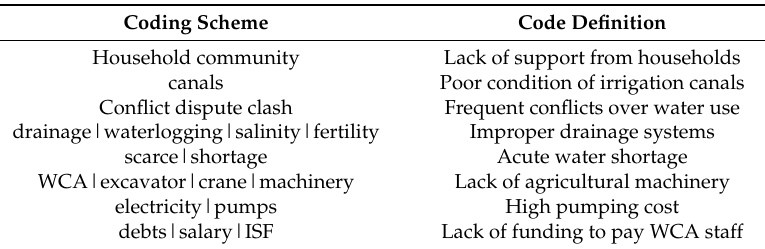
Table 2. Coding structure for the Atlas.ti